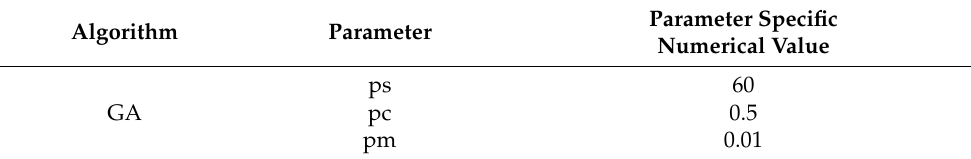
Table 3. Parameter settings of genetic algorithm.